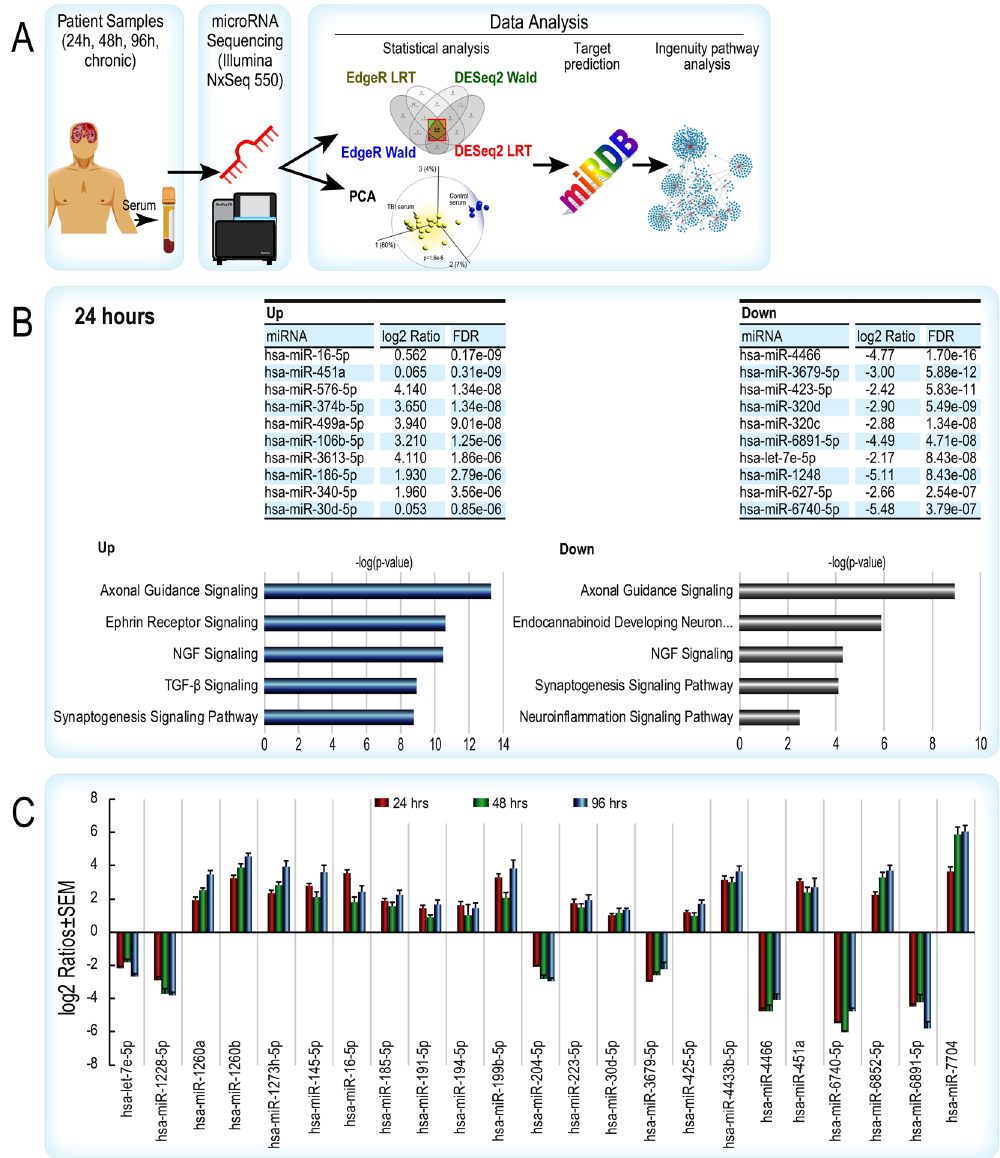
Figure 2. ( A ) Experimental workflow for miRNA-seq and bioinformatic analysis of human uninjured control and TBI patient samples. ( B ) The top 10 up- and down-regulated miRNAs by level of significance (FDR adjusted p-value) in the 24 hr patient cohort. Ingenuity Pathway Analysis of predicted gene targets show the top nervous system-related canonical pathways for the up and down miRNAs, respectively are involved in synaptic plasticity, neurorestorative signaling and neuroinflammation. The x-axes are based on the -log of the Fisher’s Exact p-value. ( C ) Consistent expression of miRNAs across three acute periods after TBI. Data is displayed graphically as the log2 ratio ± SEM (y-axis) and significant miRNAs from the LRT and Wald tests in EdgeR and DESeq2 (x-axis). Red bars indicate 24 hrs, green 48 hrs, and blue 96 hrs after TBI. SEM – standard error of the mean; LRT – likelihood ratio test; hsa – human miRNA. Data were analyzed through the use of IPA (QIAGEN Inc., Small RNA sequencing.